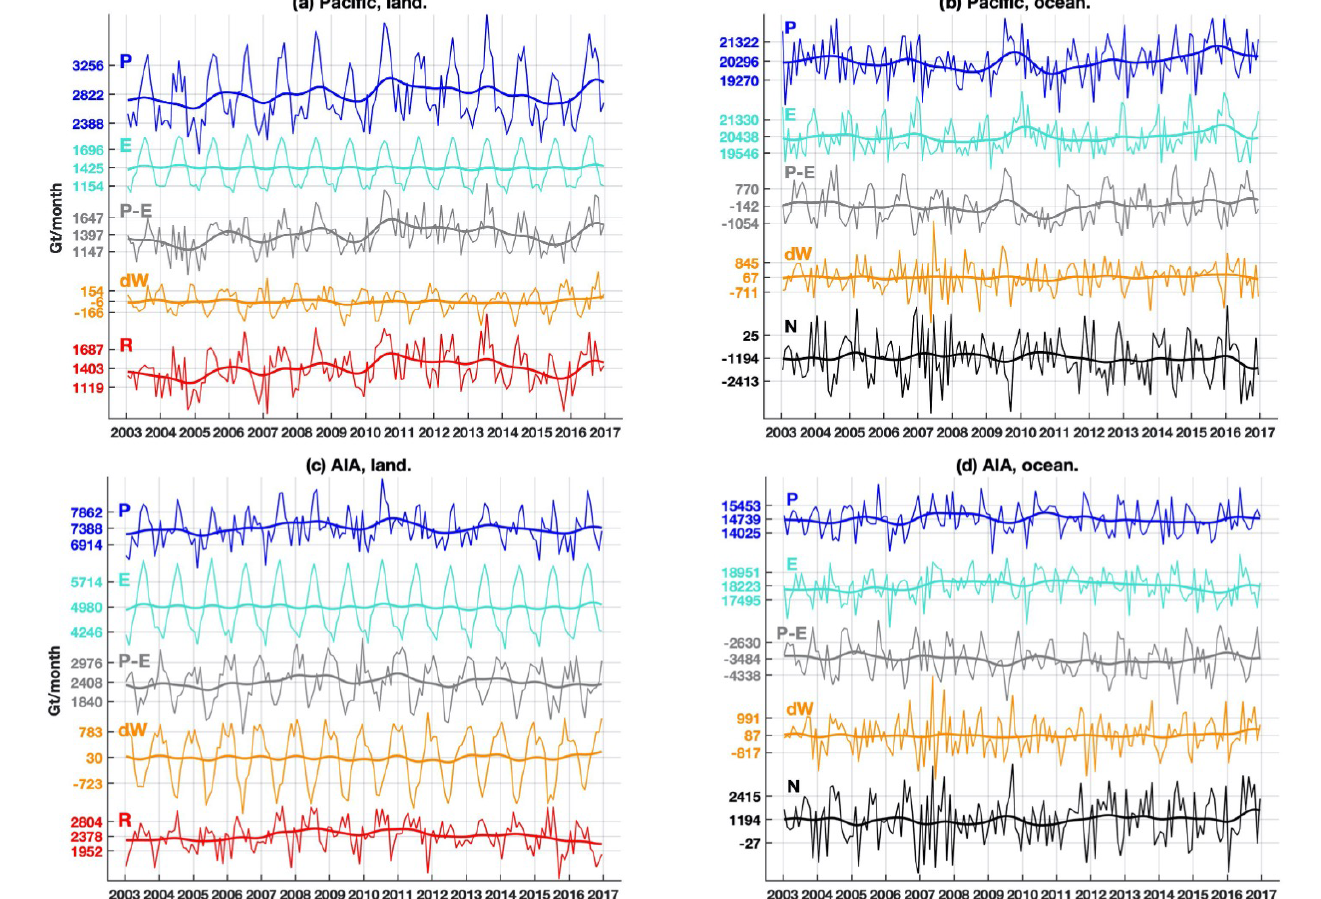
Figure 2. WT from Eqs. (1) and (2) in the Pacific (a, b) and in the Atlantic, Indian, and Arctic (AIA) oceans collectively (c, d) , as well as their drainage basins. (a, c) The associated land drainage basins and (b, d) ocean basins. Labels on the y axis correspond to the mean ± standard deviation of the associated curve. Thick lines are the low-pass-filtered signal by a Hann function of 24 months. All curves in the same panel are plotted on the same scale. P , E , and P − E are from the ERA5 dataset; dW is estimated from GRACE; R and N are estimated as a residual in Eqs. (1) and (2) respectively.